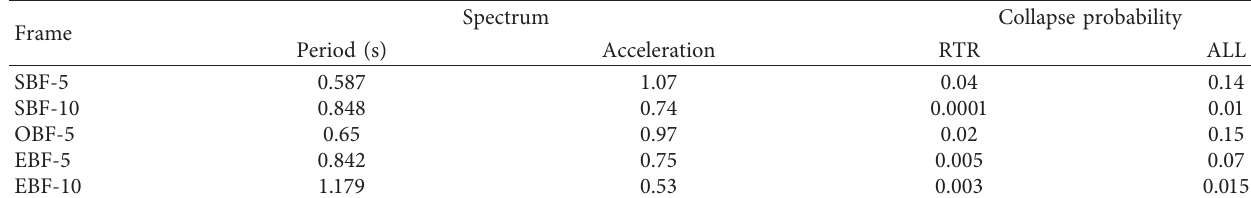
Figure 25: Fragility curves of EBF-5 and EBF-10 frames with all uncertainties. Table 11: Probability of collapse of structural frames.